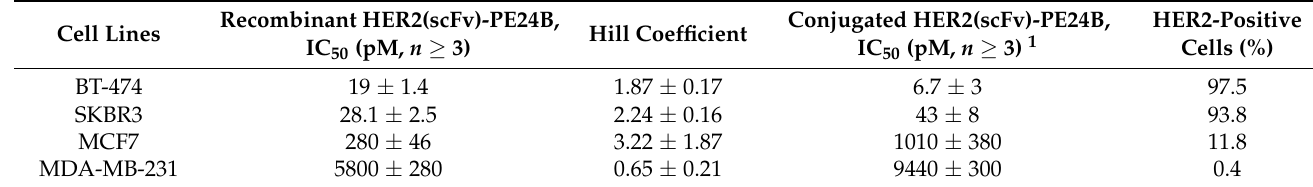
Table 2. Cytotoxicity of HER2(scFv)-PE24B and HER2 levels for the four cell lines. Cell Lines